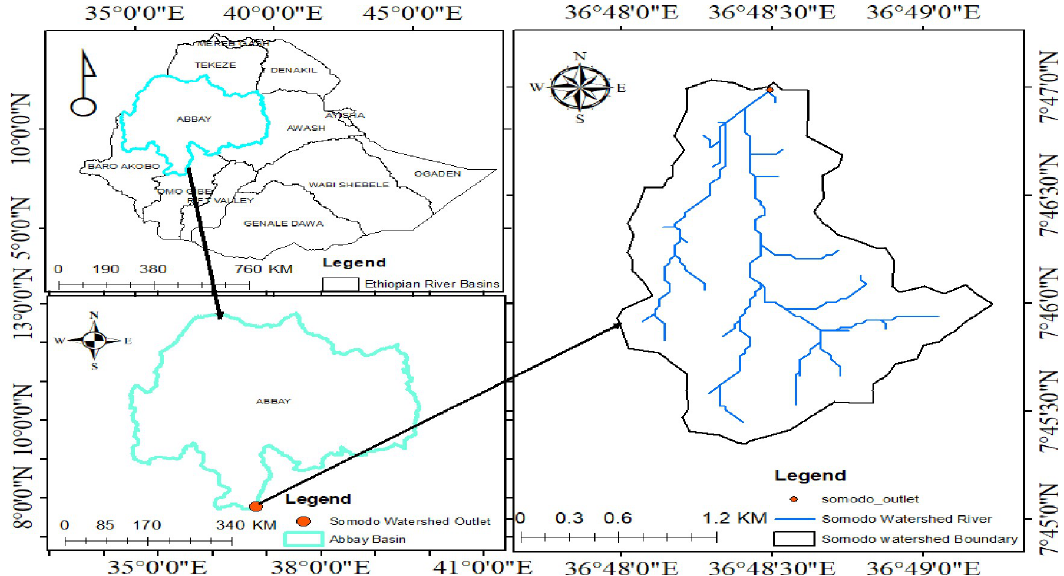
Fig 1. Map of Somodo watershed, Jimma Zone, South-western of